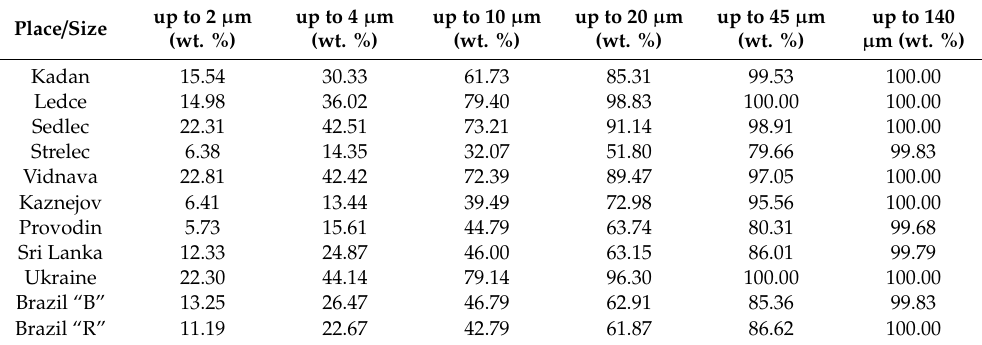
Table 5. The Particle-size Distribution in the Clay Samples Studied (wt. %).